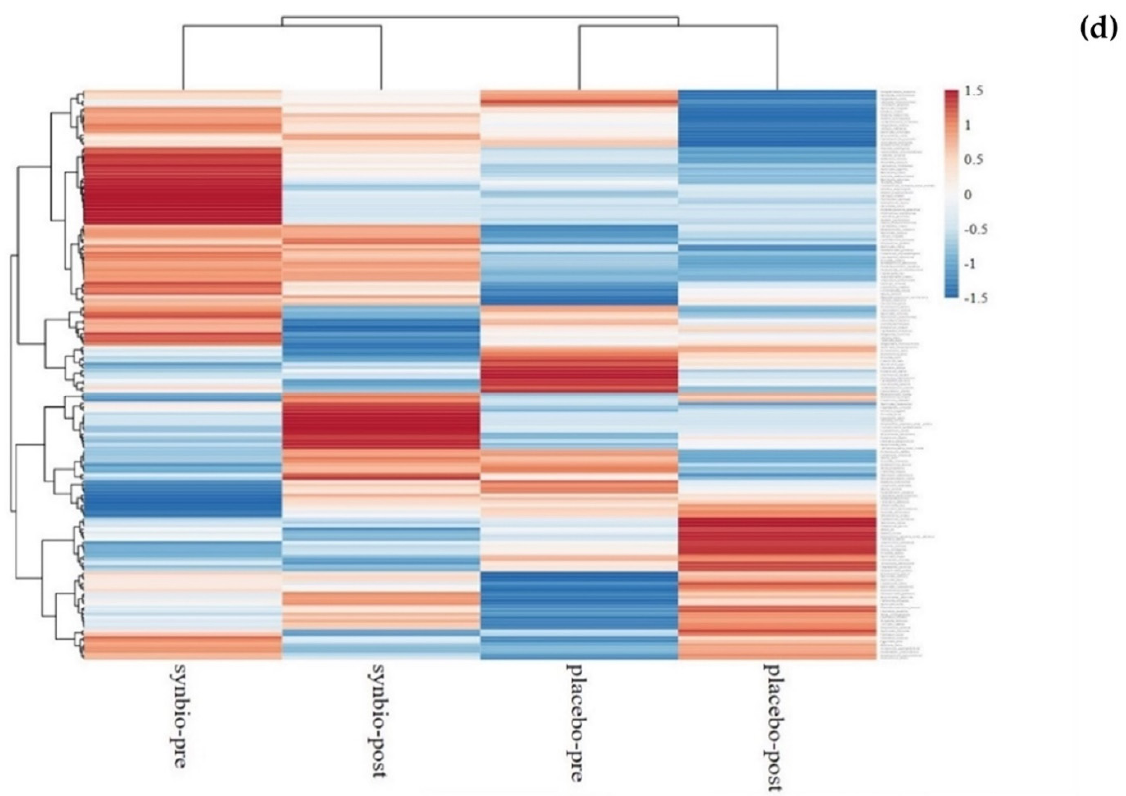
Figure 6. Changes in operational taxonomic units (OTUs): ( a ) Changes in OTU 107 and OTU 122; ( b ) Venn diagram showing the numbers of shared OTUs between groups; ( c ) Changes after intervention in both groups by heat map; ( d ) Average changes after intervention.